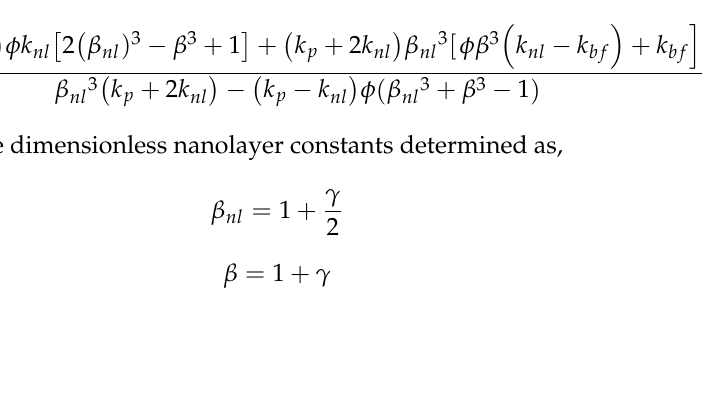
Figure 37. Depiction of nanolayer phenomena. Liquid molecules adhering to the surface of